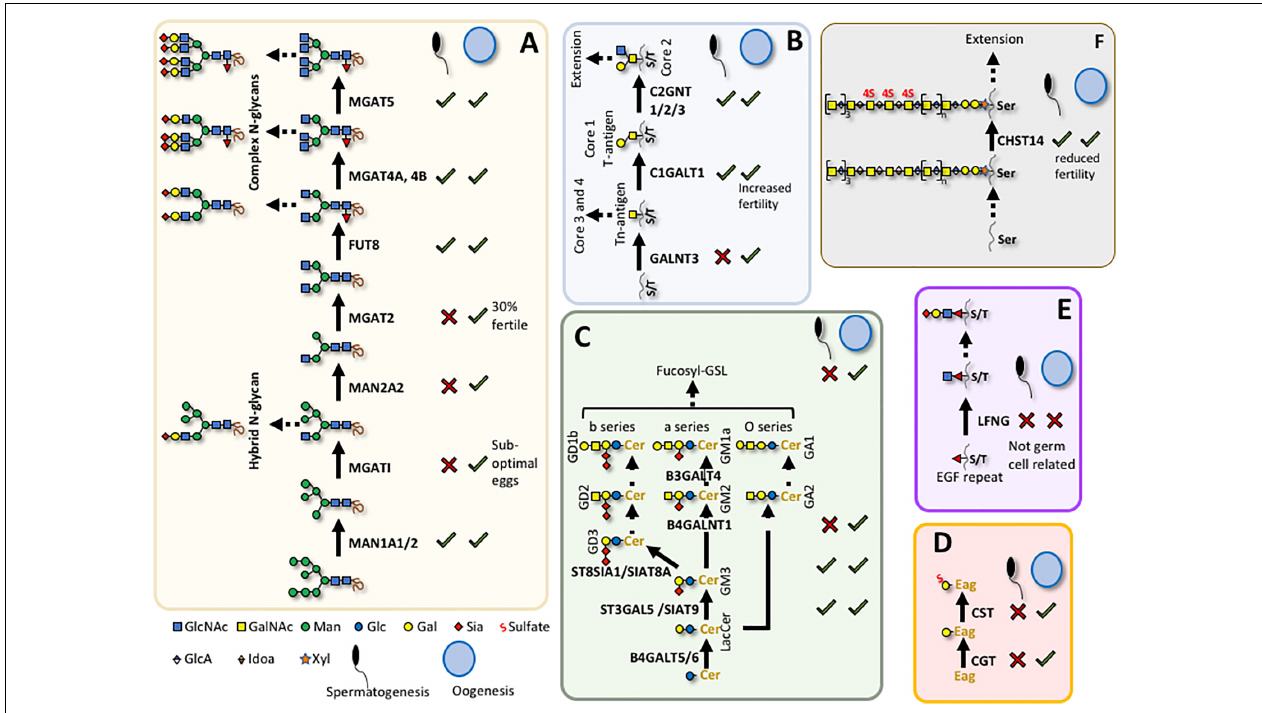
FIGURE 4 | Glycans required for spermatogenesis or oogenesis. Summary of known roles for individual glycans in mouse gametogenesis (see main text). (A) N-glycan maturation; (B) O-GalNAc core 1 and core 2 glycan synthesis; (C) Glycolipid synthesis; (D) Seminolipid synthesis; (E) O-Fucose glycan synthesis; √ indicates no known defect when related gene is deleted; Cer, (F) Chondroitin sulfate synthesis. X indicates a defect in male or female gametogenesis and ceramide; Eag, alkylacylglycerol. Sugar symbols are according to the Symbol Nomenclature for Glycans (Varki et al.,